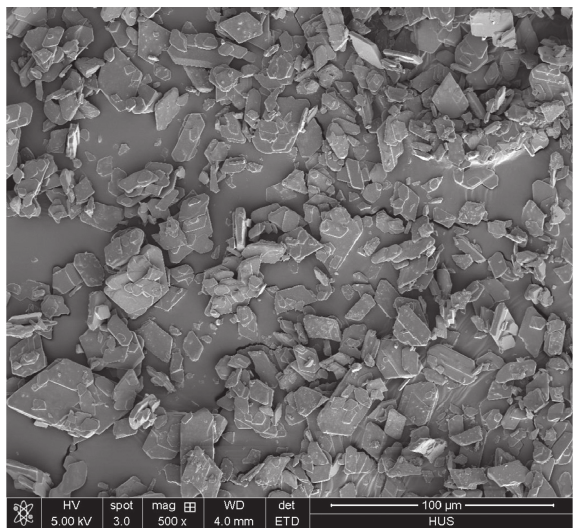
Figure 5: The SEM image of the synthesized